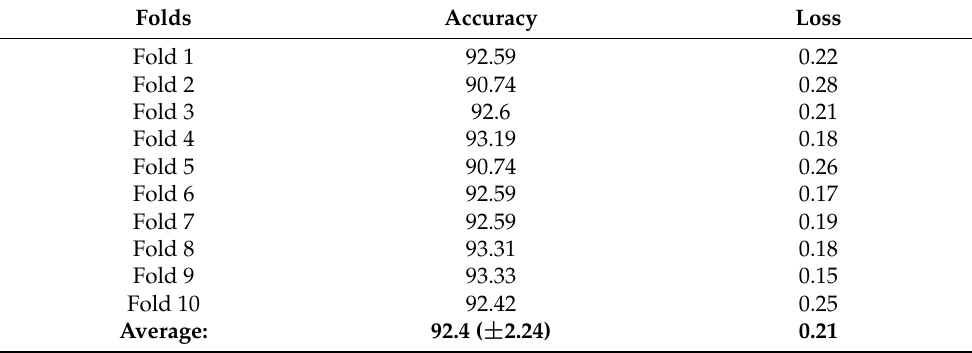
Table 6. Runs of 10-fold cross-validation for the proposed Red Green Blue (RGB). Folds